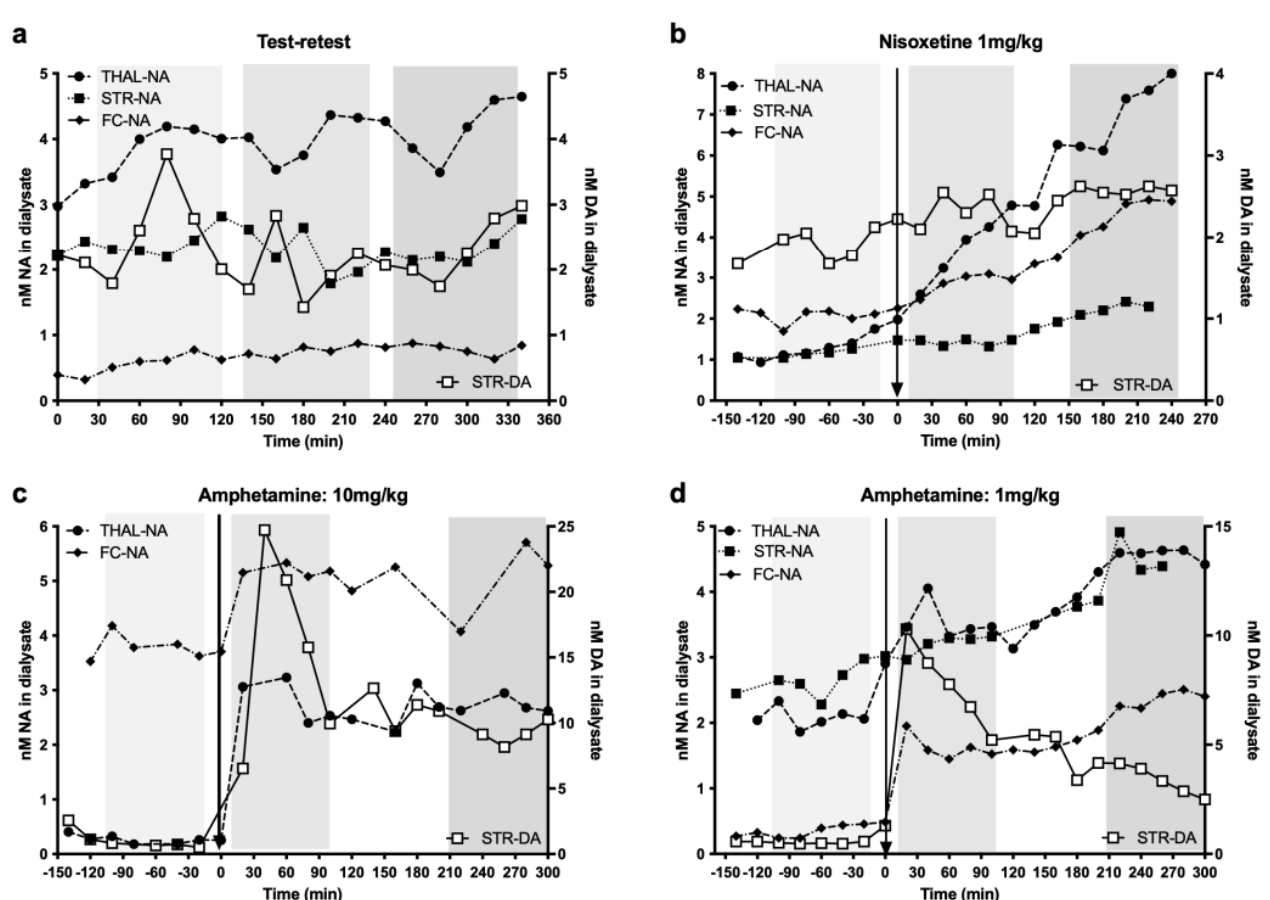
Figure 4. Example of the changes in extracellular NA concentration in response to various challenges: ( a ) saline (test–retest), ( b ) nisoxetine (1 mg/kg) and at 2 doses of amphetamine: ( c ) 10 mg/kg and ( d ) 1 mg/kg. The vertical light-grey-shaded columns indicate the times during which the PET scans were acquired at baseline and after challenge. Note the lack of large, sustained changes throughout the day in the absence of a challenge (test–retest) and the progressive increase in NA after administering nisoxetine. In contrast, note the sharp rise in NA after amphetamine. As an index of specificity, please also note the lack of large changes in striatal DA (open square) in test–retest and nisoxetine (a specific NET inhibitor) and the large increase following amphetamine.